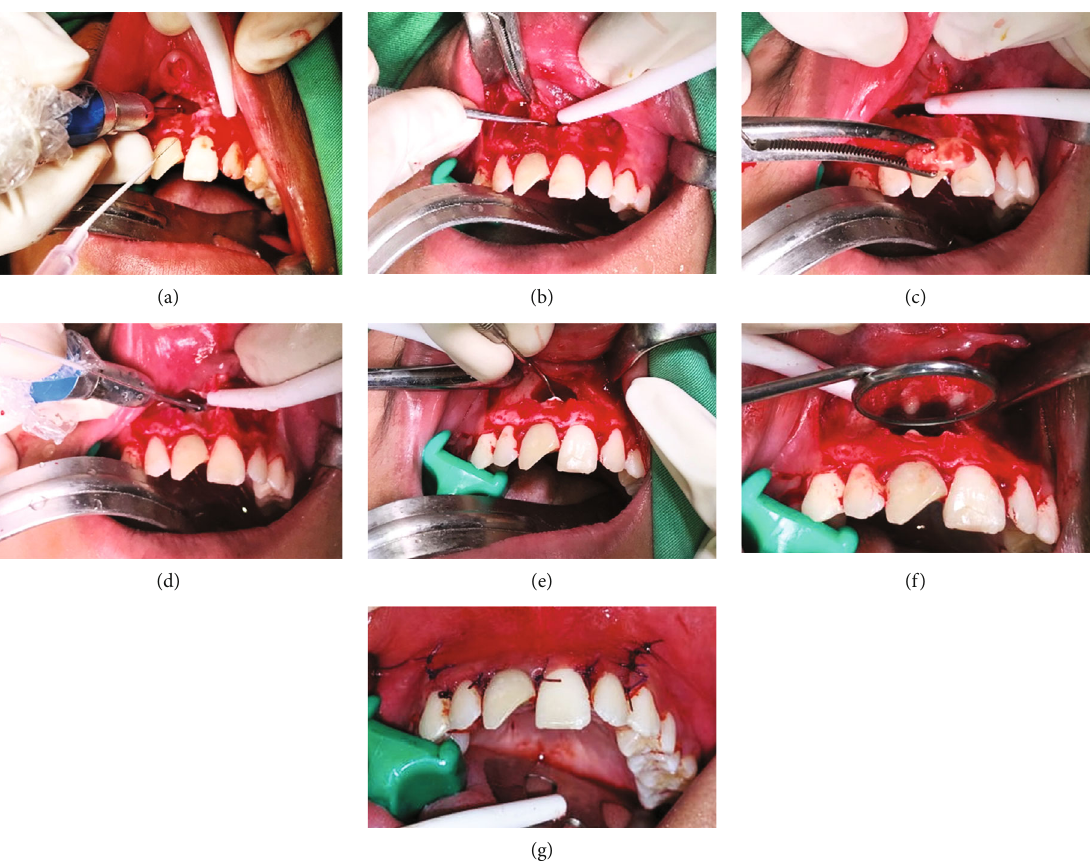
Figure 5: Surgical procedure: (a) buccal window; (b) curettes of granulation tissue; (c) extraction of mesiodens; (d) apex resection; (e) MTA and GIC application; (f) evaluation; (g) suturing.